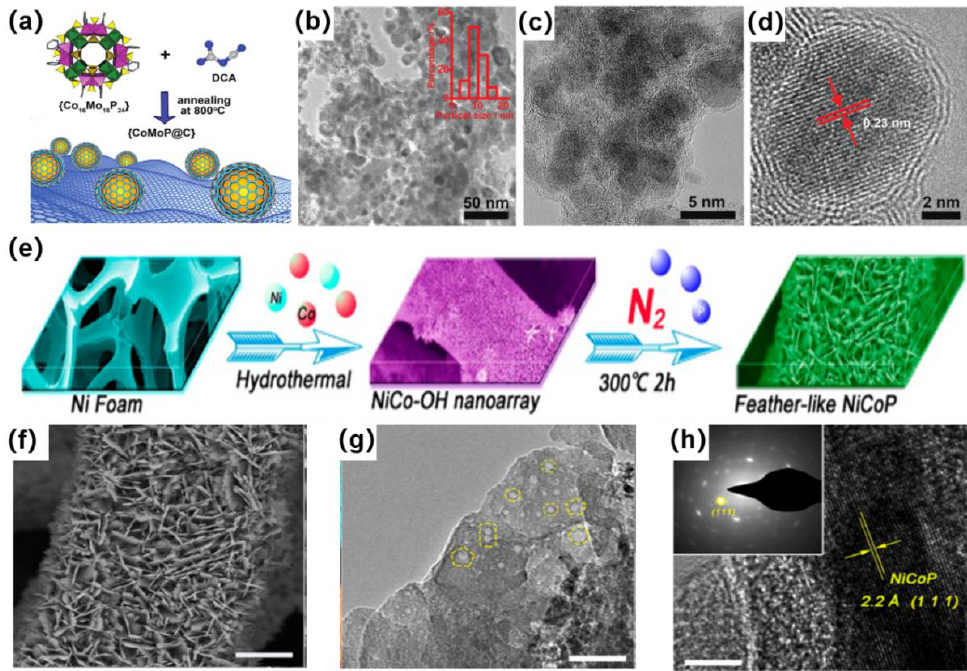
Figure 7. ( a ) Schematic diagram of the synthesis of CoMoP@C, ( b ) TEM images of CoMoP@C, and ( c , d ) HRTEM images of CoMoP@C. Reproduced with permission from [115]. Copyright © 2017 Royal Society of Chemistry, ( e ) Synthesis of NiCoP and schematic diagram of its structure, ( f ) SEM images of the NiCoP, ( g ) TEM images, and ( h ) HRTEM image and SAED pattern (inset) of the NiCoP. Reproduced with permission from [96]. Copyright © 2019, ACS Appl. Energy Mater.